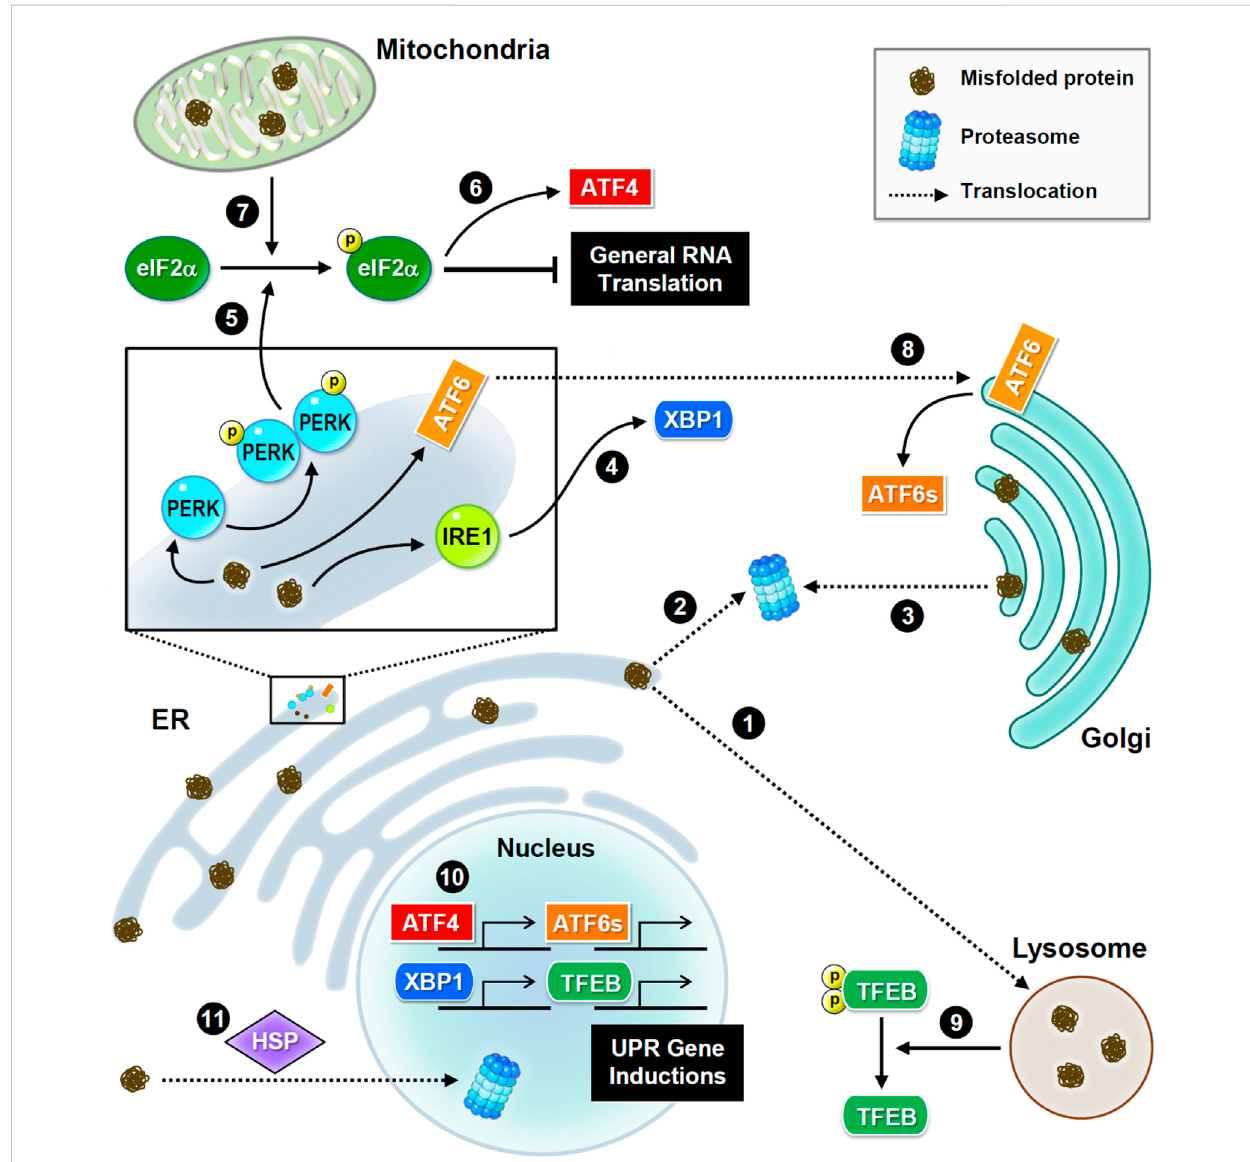
FIGURE 2 Subcellular proteostasis and UPR signaling. Schematic presentations of proteostasis signaling and protein traf fi cking in distinct organelles. Main stress sensors and transcription factors are presented. Misfolded proteins are transferred between the ER and Golgi apparatus for refolding, or to the lysosome or nucleus for degradation. In the ER, three major UPR signaling pathways trigger proteostatic processes. First, PERK phosphorylates eIF2 α to inhibit the assembly of the initiation ternary complex, thereby suppressing general translation. Additionally, mitochondrial damage also induces phosphorylation of eIF2 α . Conversely, some proteins such as transcription factor ATF4 are preferentially produced. Second, IRE1 mediates RNA splicing and promotes the synthesis of transcription factor XBP1. Third, ATF6 is transferred to the Golgi apparatus and cleaved into a short and active form. Furthermore, the proteome stress dephosphorylates and activates transcription factor TFEB. Together, these transcription factors drive the induction of UPR genes to ensure